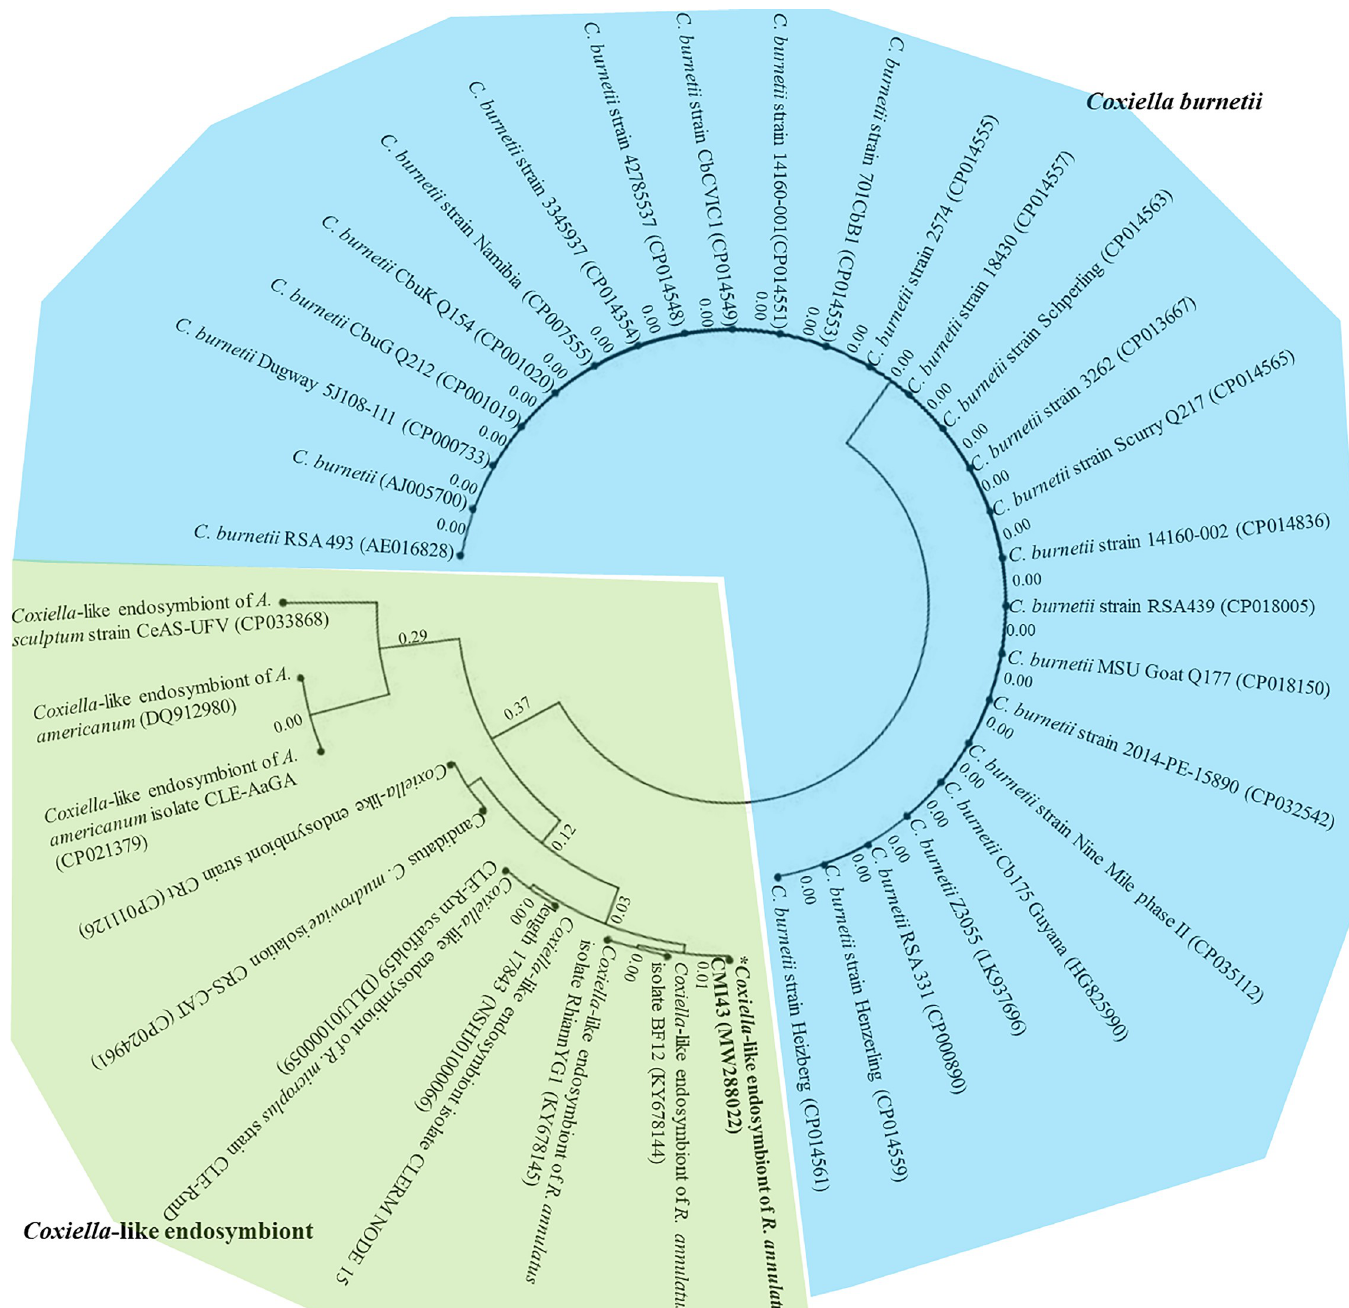
Fig 1. Phylogenetic cladogram of partial dnaK nucleotide sequences of Coxiella sp. Phylogenetic tree showing the evolutionary divergence among the different partial dnaK nucleotide sequences of Coxiella sp. The cladogram shows appropriate distances among C . burnetii (labeled with blue color) and CLEs (labeled green color). https://doi.org/10.1371/journal.pone.0249354.g001 1.0, while CLE indicated high variation in nucleotides and less similarity along nucleotide sequences (S1 Fig). The entropy [H(x)] illustrated the high variation along nucleotide sequences of partial dnaK -encoding genes (Fig 2). And so, on top of that, a multiple alignment comparison of the 10 CLE dnaK sequences was demonstrated in S2 Fig which differed among themselves.